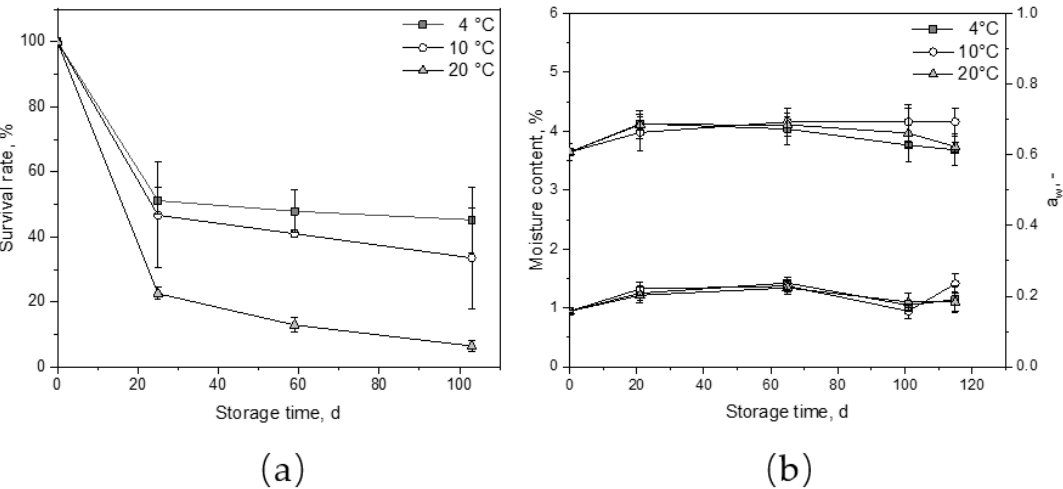
Figure 3. Survival rate of Lactobacillus paracasei ssp. paracasei F19 ( a ) and moisture content and a w ( b ) as a function of storage time.